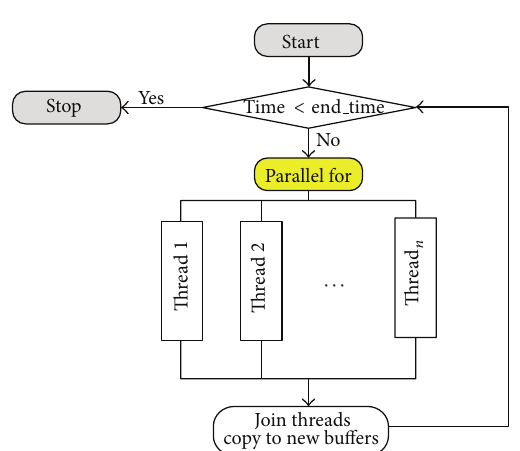
Figure 4: Threads are created based on each